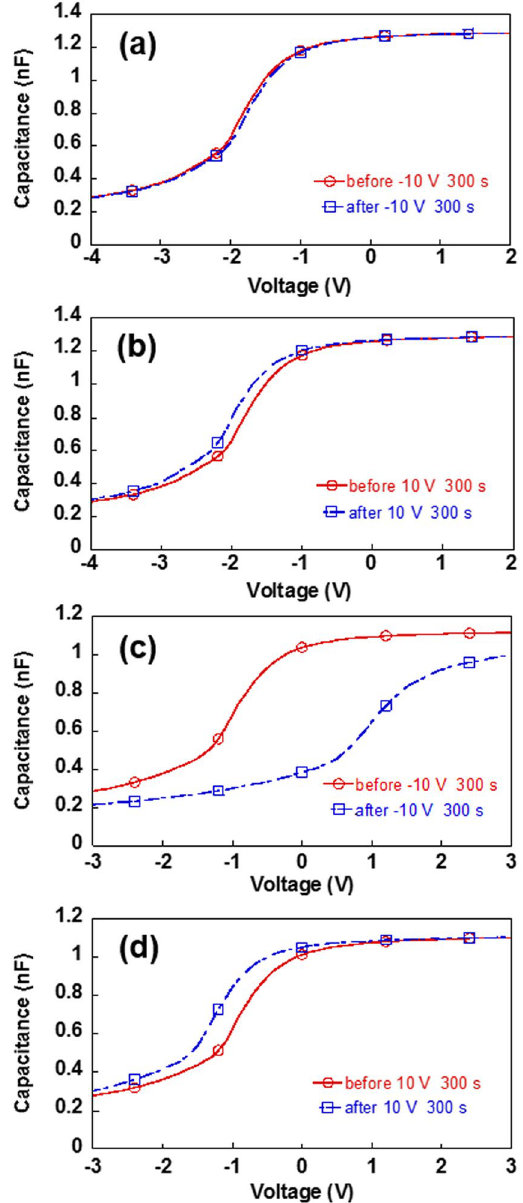
Figure 2. C - V programming characteristics at room temperature for the capacitor of ZEP520a without fullerene after writing at ( a ) − 10.0 V and ( b ) 10.0 V for 300 s and for the capacitor of ZEP520a containing PCBM after writing at ( c ) − 10.0 V and ( d ) 10.0 V for 300 s. Solid lines are for before applying the gate voltage, and dash- dotted lines are for after applying the gate